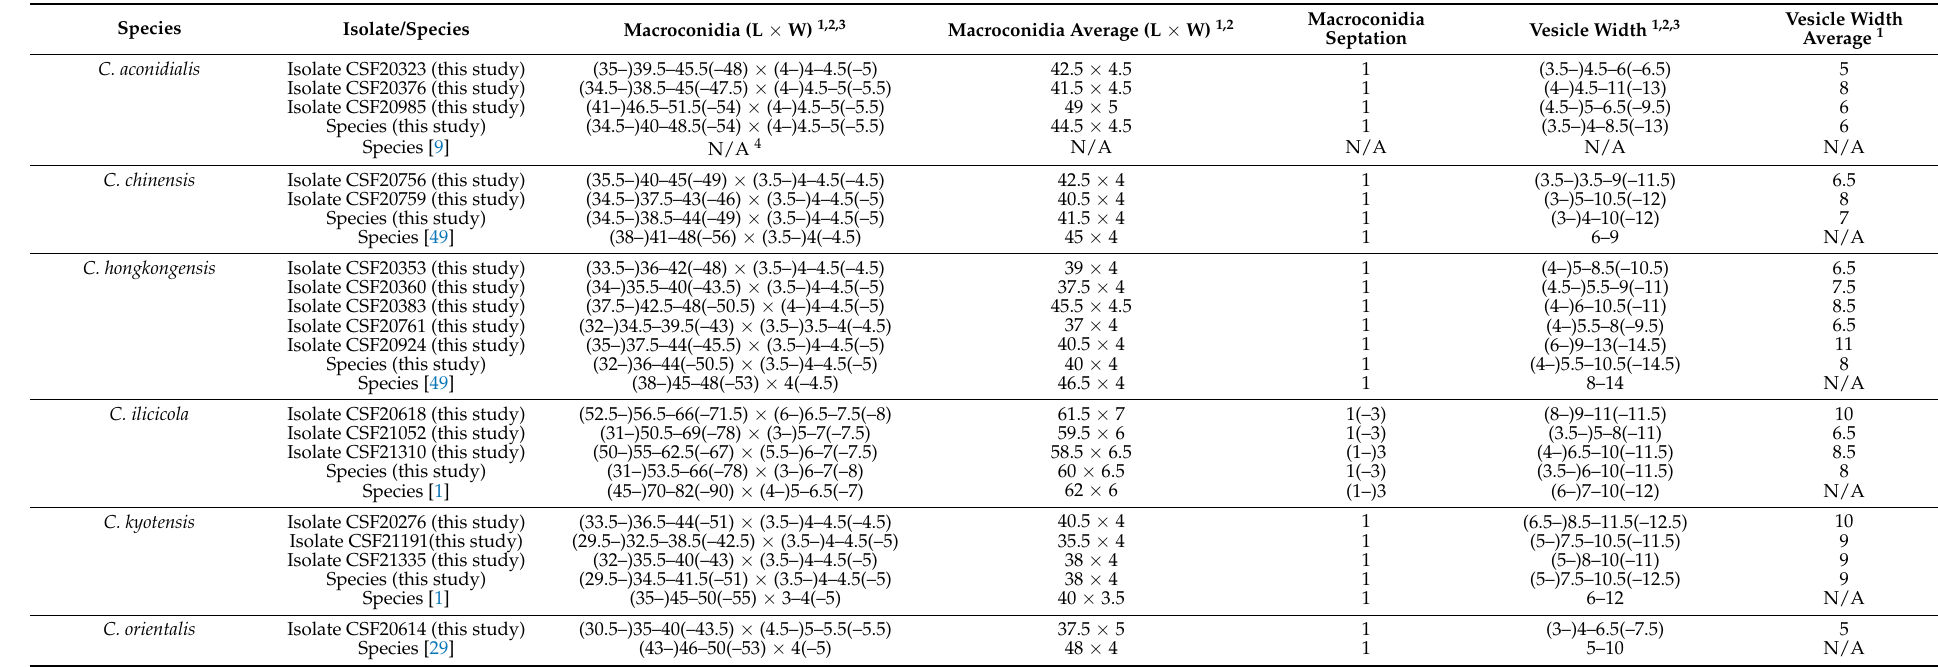
Table 6. Morphological comparisons of Calonectria isolates and species obtained in the current